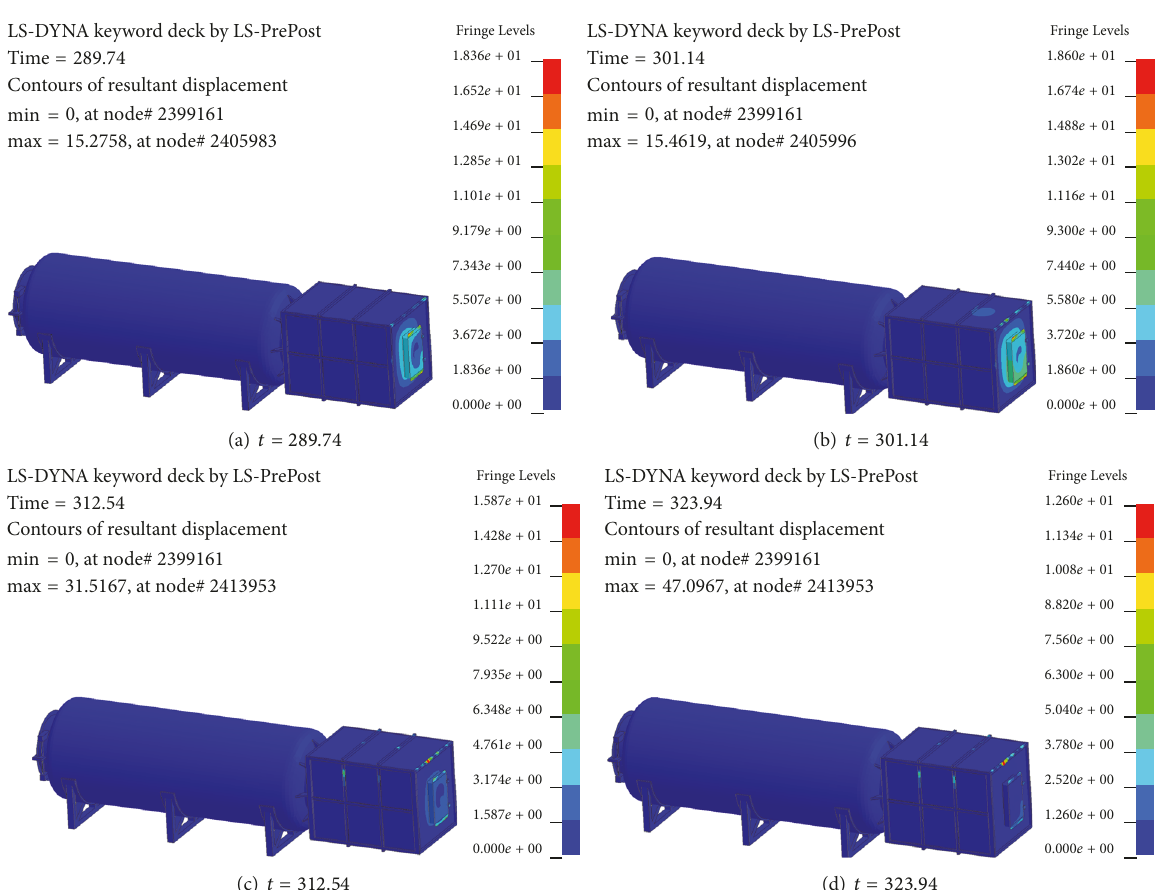
Figure 10: Displacement change for the rescue